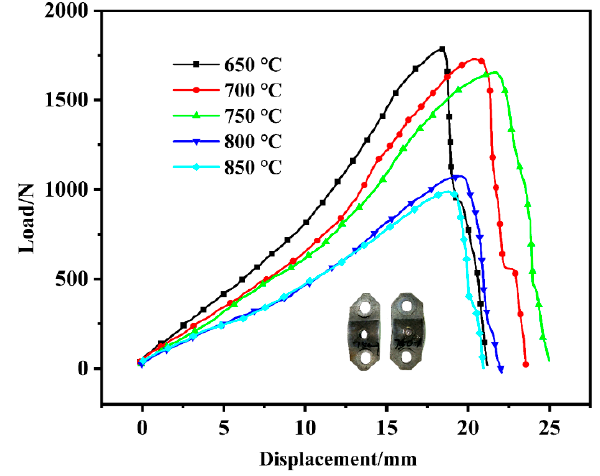
Figure 9. Load–displacement curves of high temperature cross-tension tests.